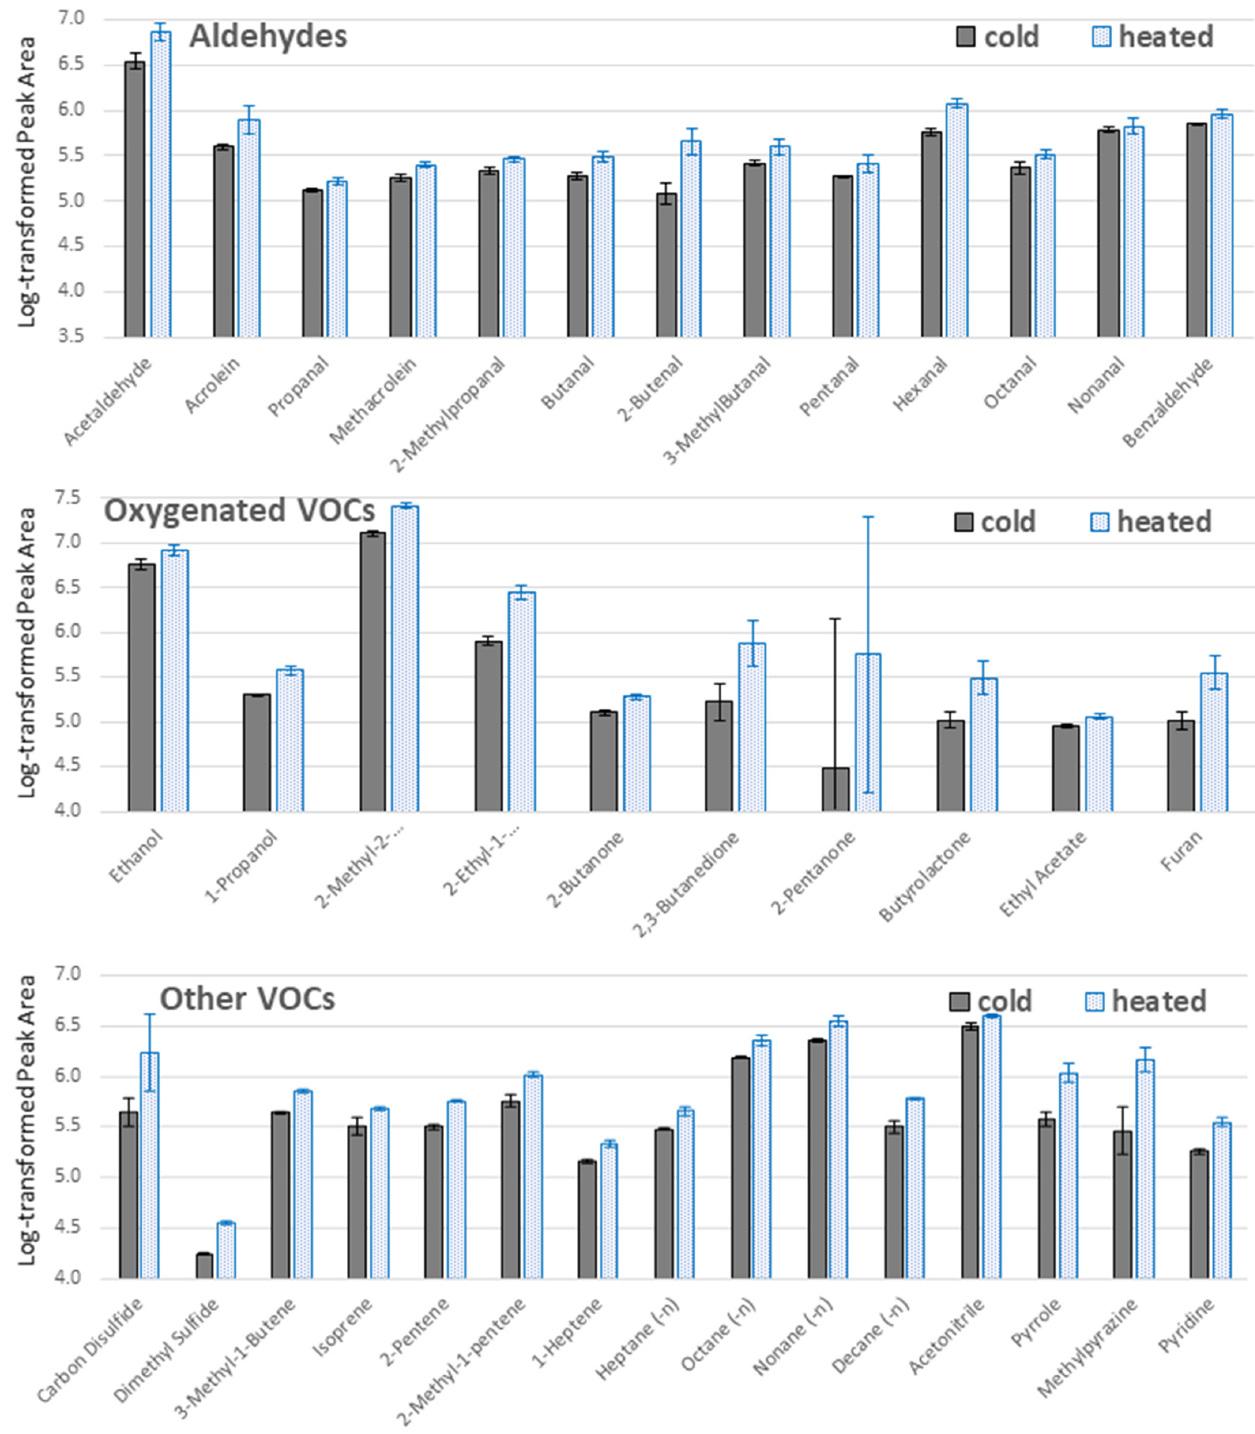
Figure 3. Influence of temperature on VOCs extraction from a pooled medium headspace on HLB sheets according to IN-HS sampling protocol. The y -axis represents log-transformed peak area values, where means are given with a respective standard deviation for three replicates ( n = 3) for each temperature: ambient of ~20 °C (“cold”, grey boxes) and elevated to 37 °C (“heated”, blue boxes).